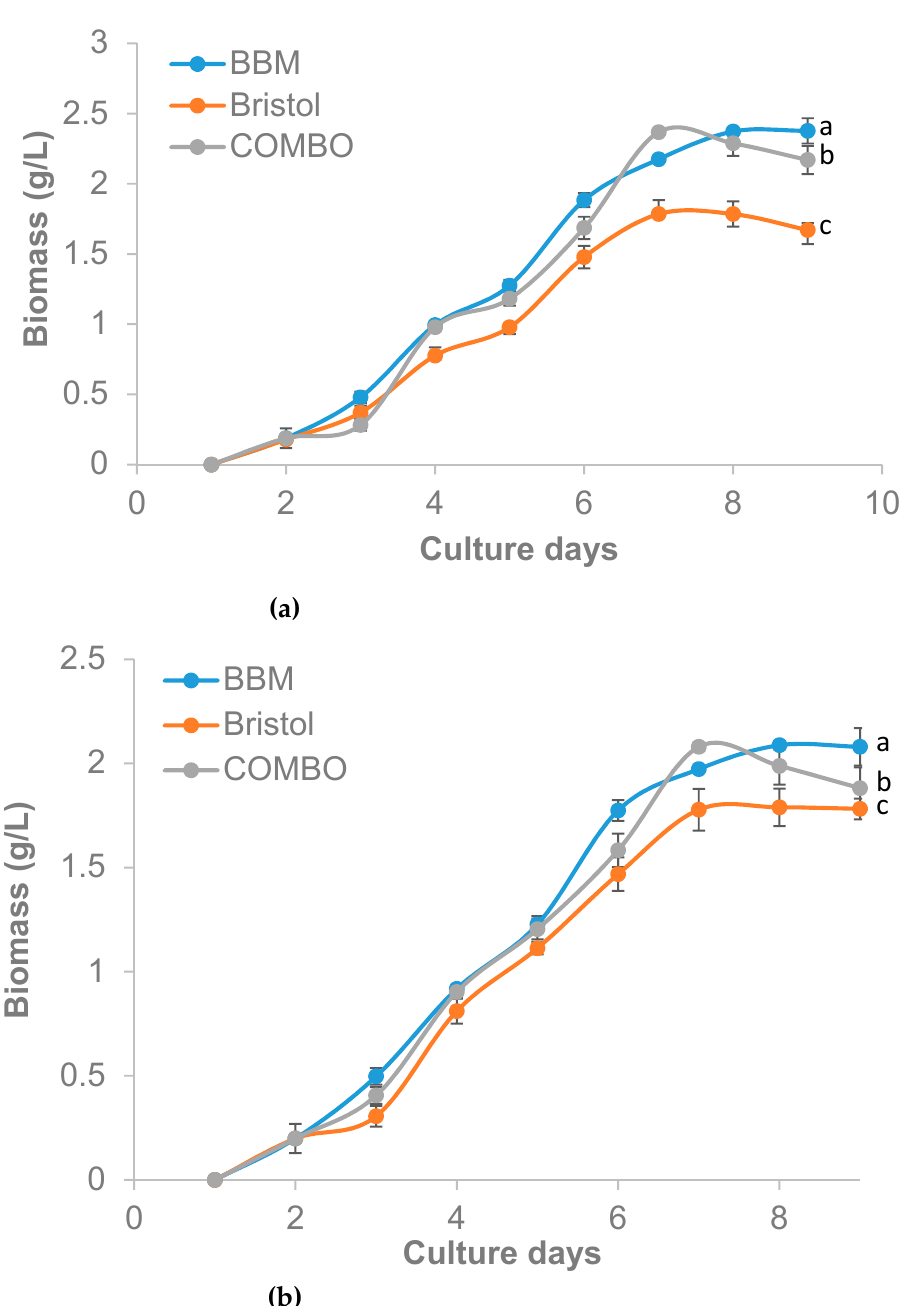
Figure 4. Biomass of Ankistrodesmus falcatus in 100% ( a ) and 50% ( b ) concentration (means ± standard errors). Line with different lowercase letters differs significantly ( p ≤ 0.05).